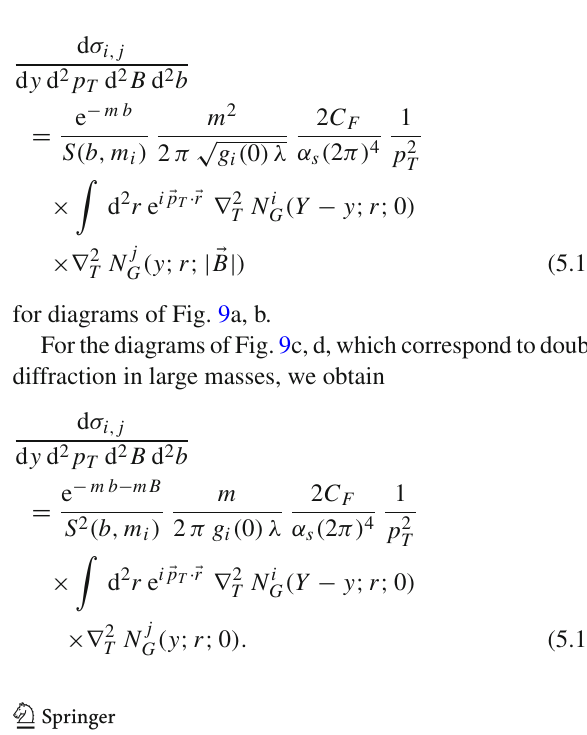
Fig. 10 v n versus p T at W = 13TeV for non-enhanced diagram of Fig. 3 and sum of all